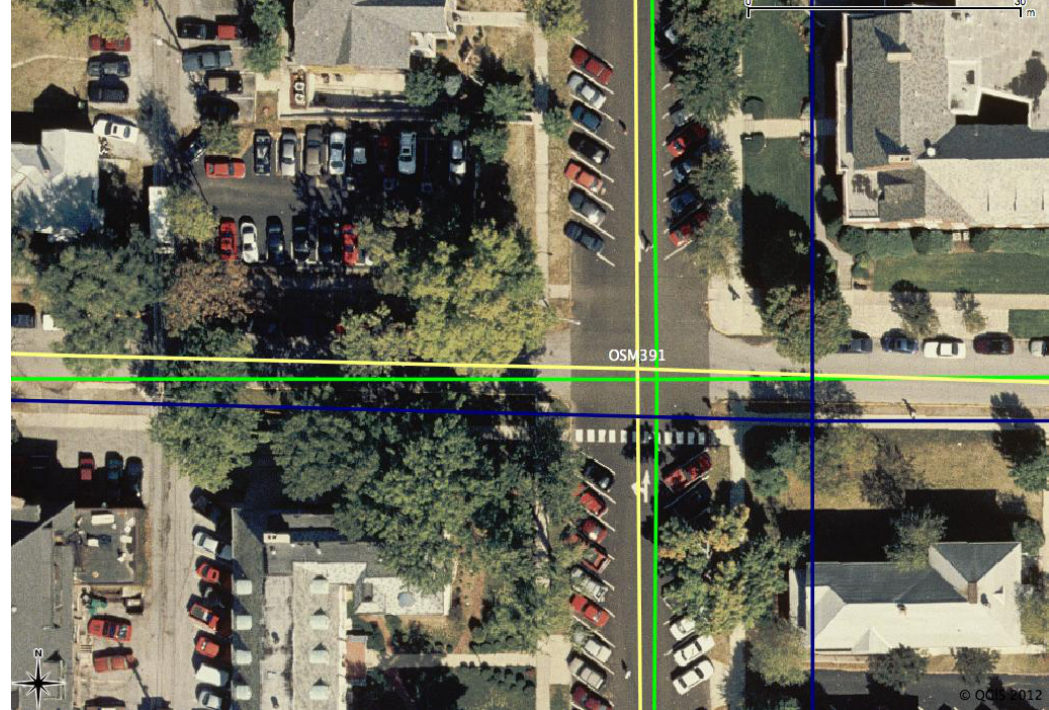
Figure 8. Close up view showing OSM, TNM, and TIGER 07